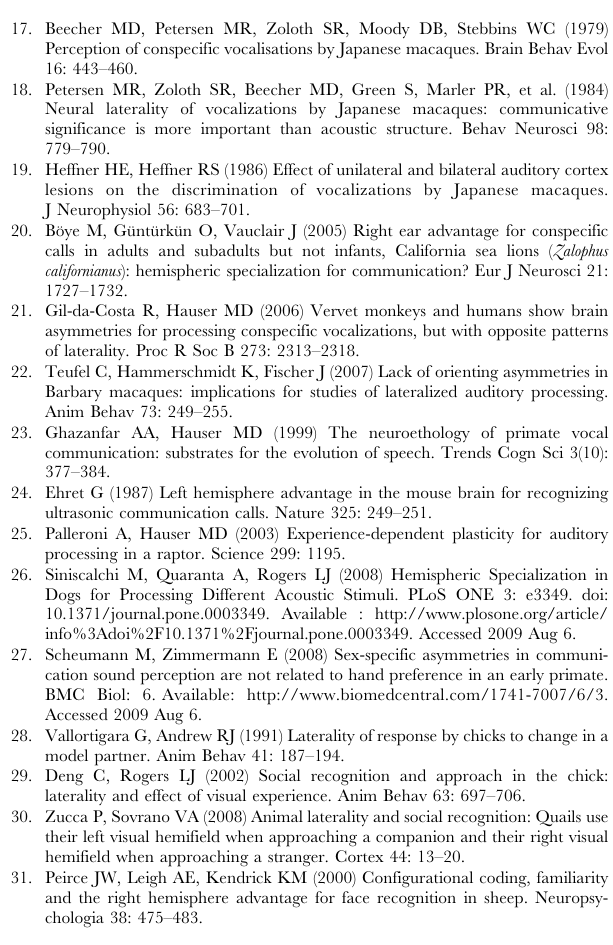
Table S2 Number of animals that turned their head more to the right, left, or equally to both sides (ambivalent) for the different playback categories, based on all 3